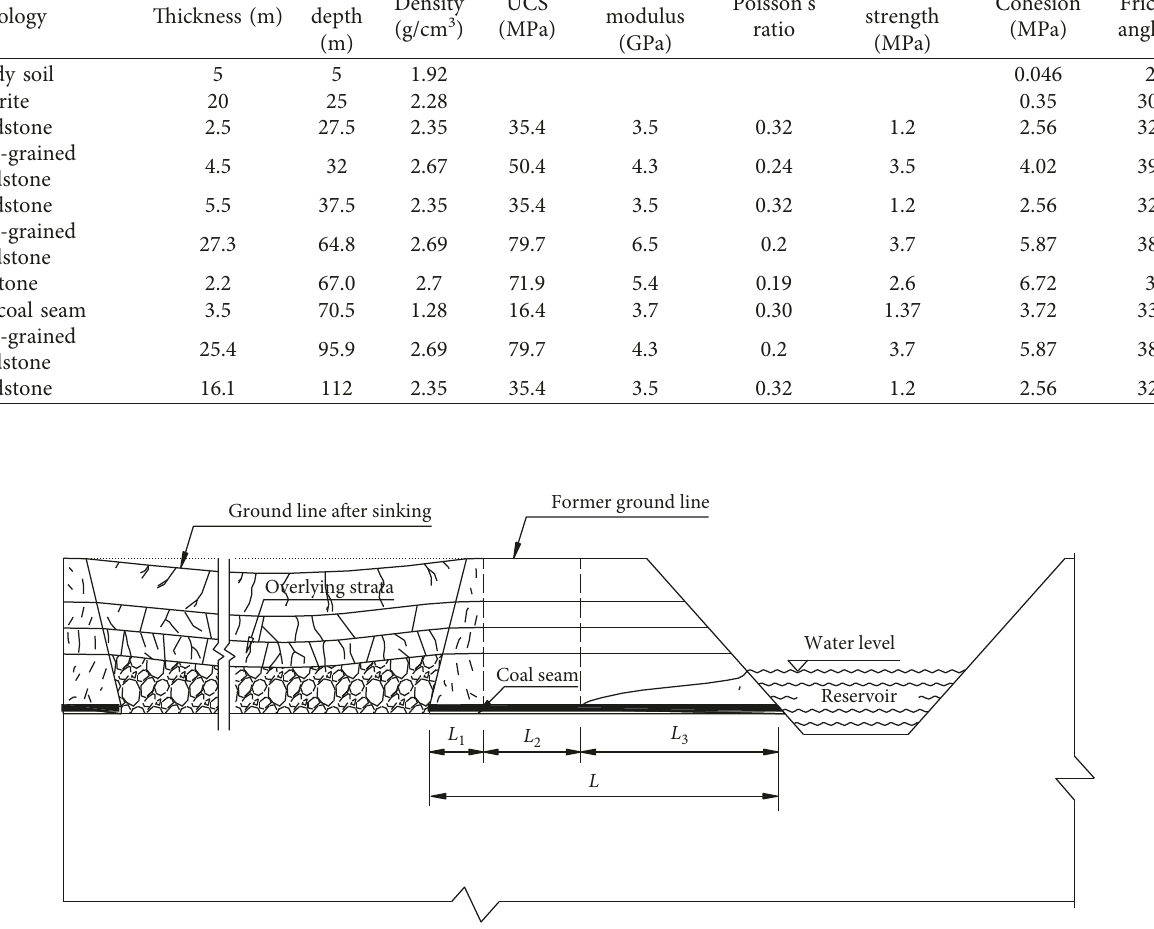
Figure 3: Analysis model of the waterproof coal pillar in a coal seam located close to a reservoir.